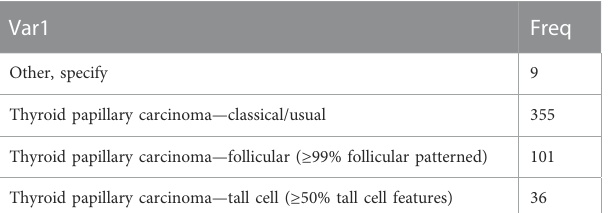
TABLE 1 Pathological types of thyroid cancer.